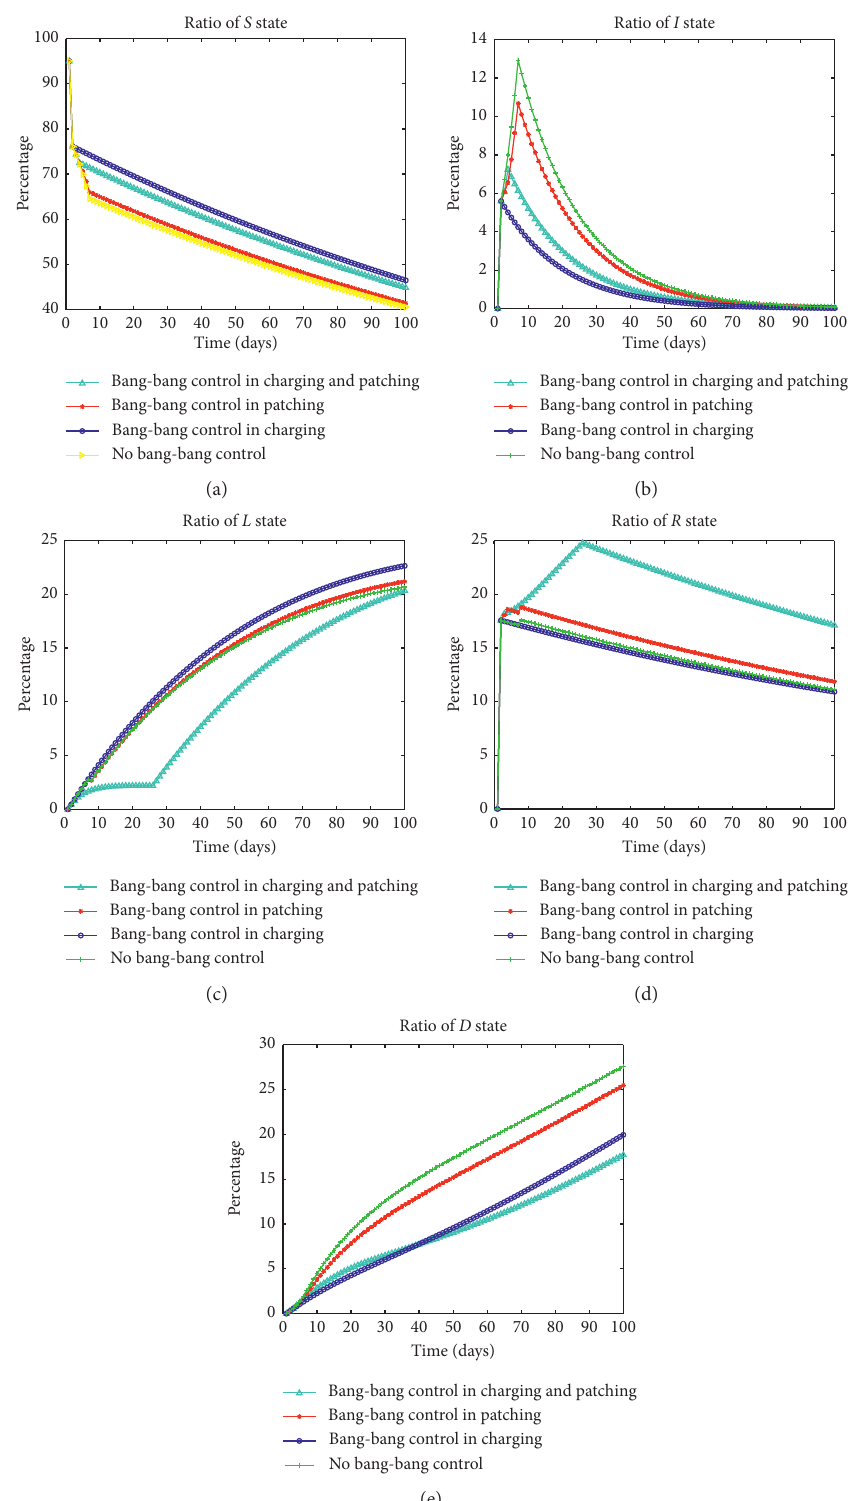
Figure 7: Evolution of five types of nodes under four control combinations. Unlike the previous section, the research factor considered in Section 4.2.1 is the control combination applied to charging and patching. This section considers the control combination of bang-bang control and square control. If bang-bang control is only applied to patching on high-energy nodes, then square control is applied to charging and patching on low-energy nodes. Similarly, if bang-bang control is used to low-energy nodes, then high-energy nodes use square control. If UAVs do not use bang-bang control, then they adopt square control. (a) The number of S -nodes. (b) The number of I -nodes. (c) The number of L -nodes. (d) The number of R -nodes. (e) The number of D